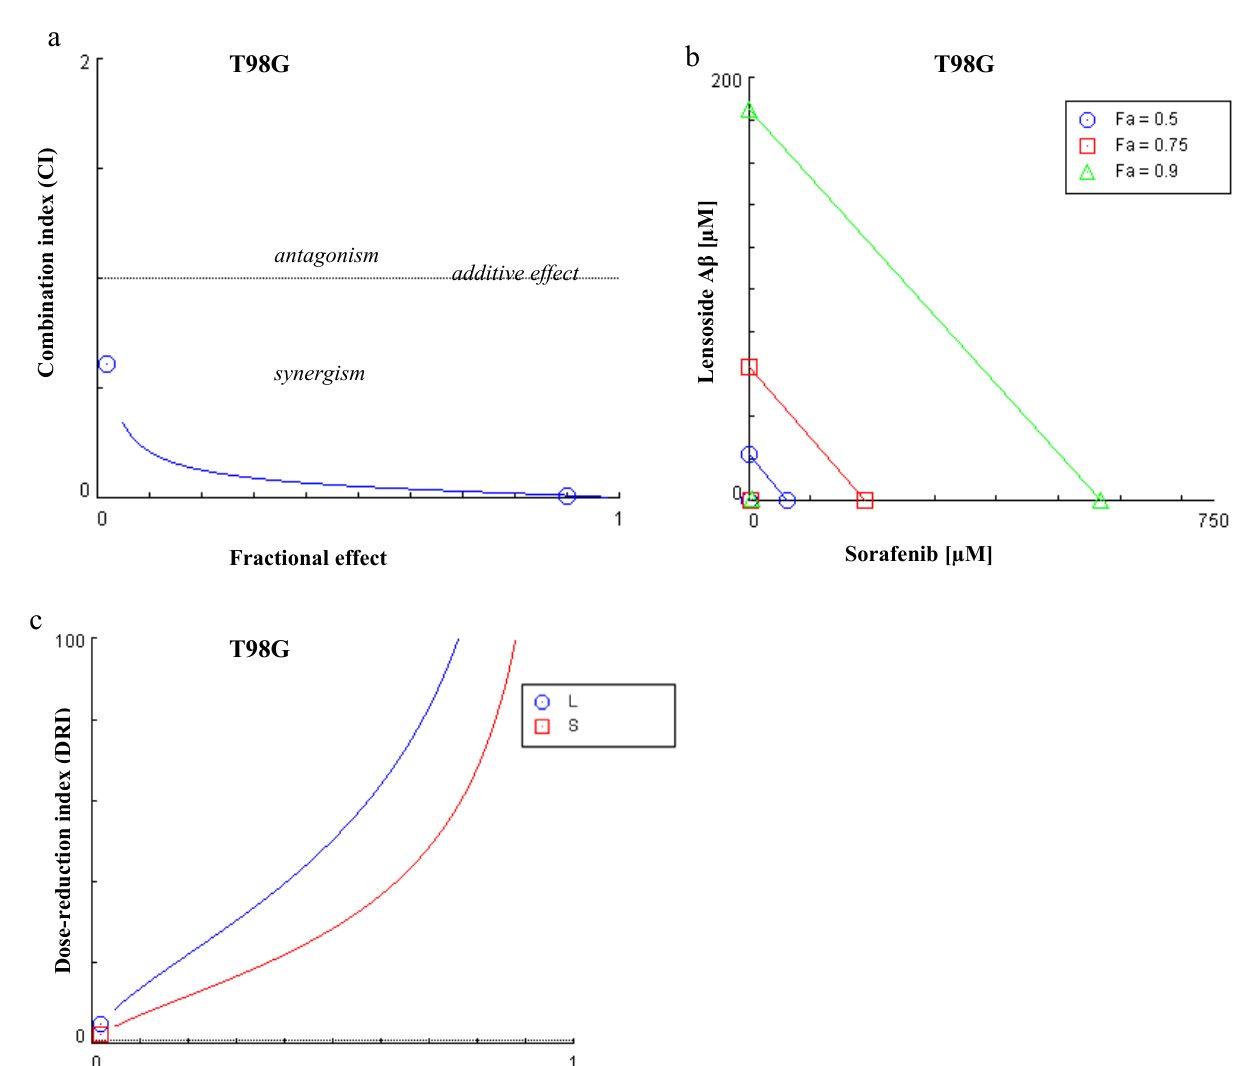
Figure A2. Lensoside A β (L) and sorafenib (S) combination treatment. ( a ) Combination index (CI) plot: The combination index is plotted as a function of Fa (fractional effect). ( b ) Isobologram for combination: isobologram at IC50, IC75, and IC90. ( c ) the Fa-DRI (dose reduction index) plot (Chou-Martin plot). Combination index (CI) and dose reduction index (DRI) were calculated according to the method of Chou and Talalay using the Compusyn software. CI < 1, CI = 1 and CI > 1 indicate synergistic effect, additive effect, and antagonistic effect, respectively. The combination of lensoside A β with sorafenib in the T98G line showed a synergistic effect. It was stronger when the higher dose was used, which is extremely important in anti-cancer therapy (for IC97, CI = 0.01). Moreover, the combination treatment significantly reduced the doses of both drugs (DRI > 1), which in a single application would have to be higher to obtain the same effect. For the experimentally determined dose (50 µ M of lensoside A β and 1 µ M of sorafenib), the CI and Fa were 0.01 and 0.9, respectively. Therefore, these concentrations were used in the research.